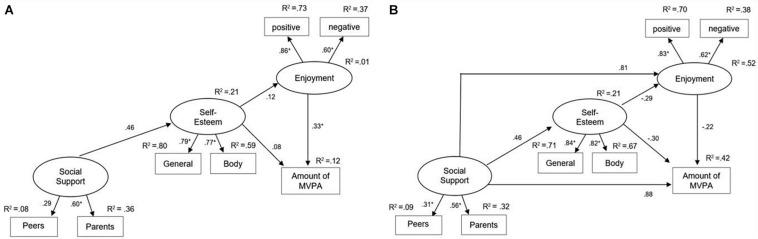
Original (A) and adapted model (B) for Study 1. Standardized regression weights are presented next to the arrows with ∗p < 0.05.